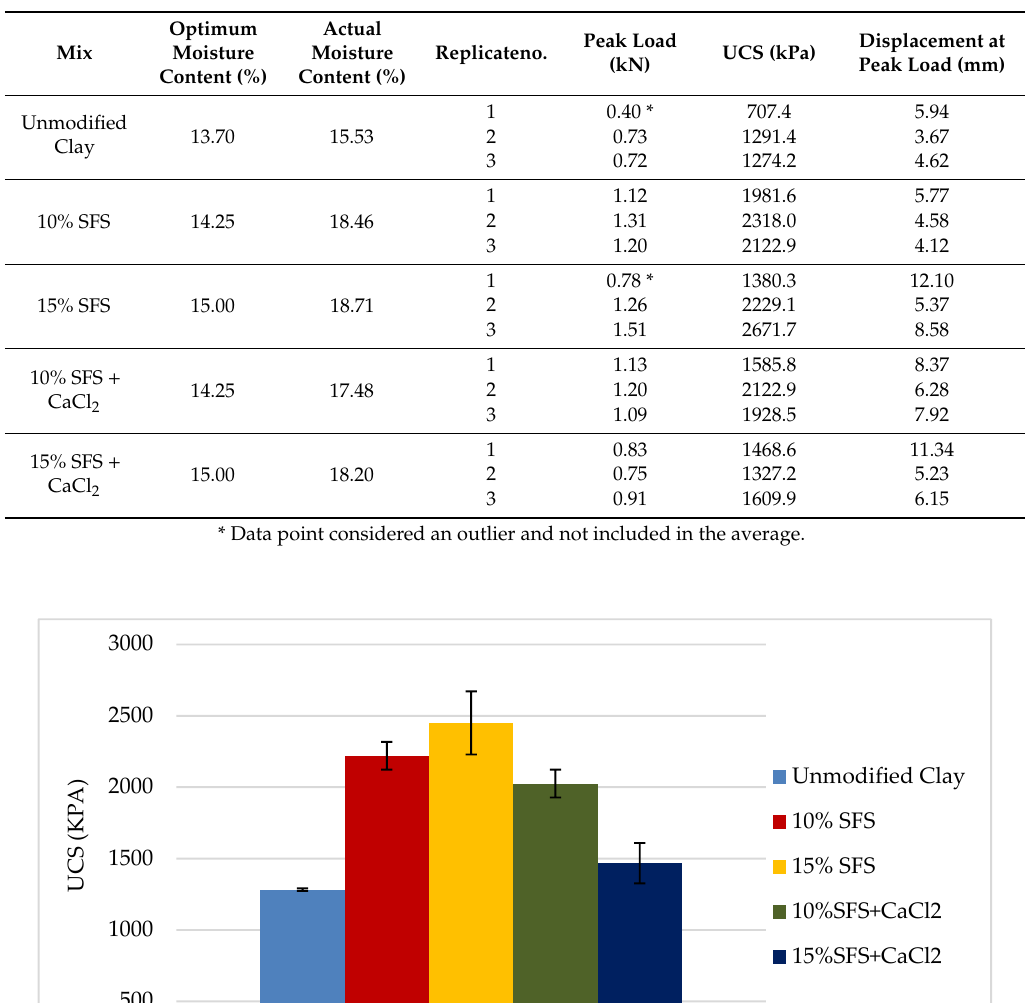
Table 8. Values of unconfined compressive strength (UCS), actual moisture, target moisture, and displacement at peak load.